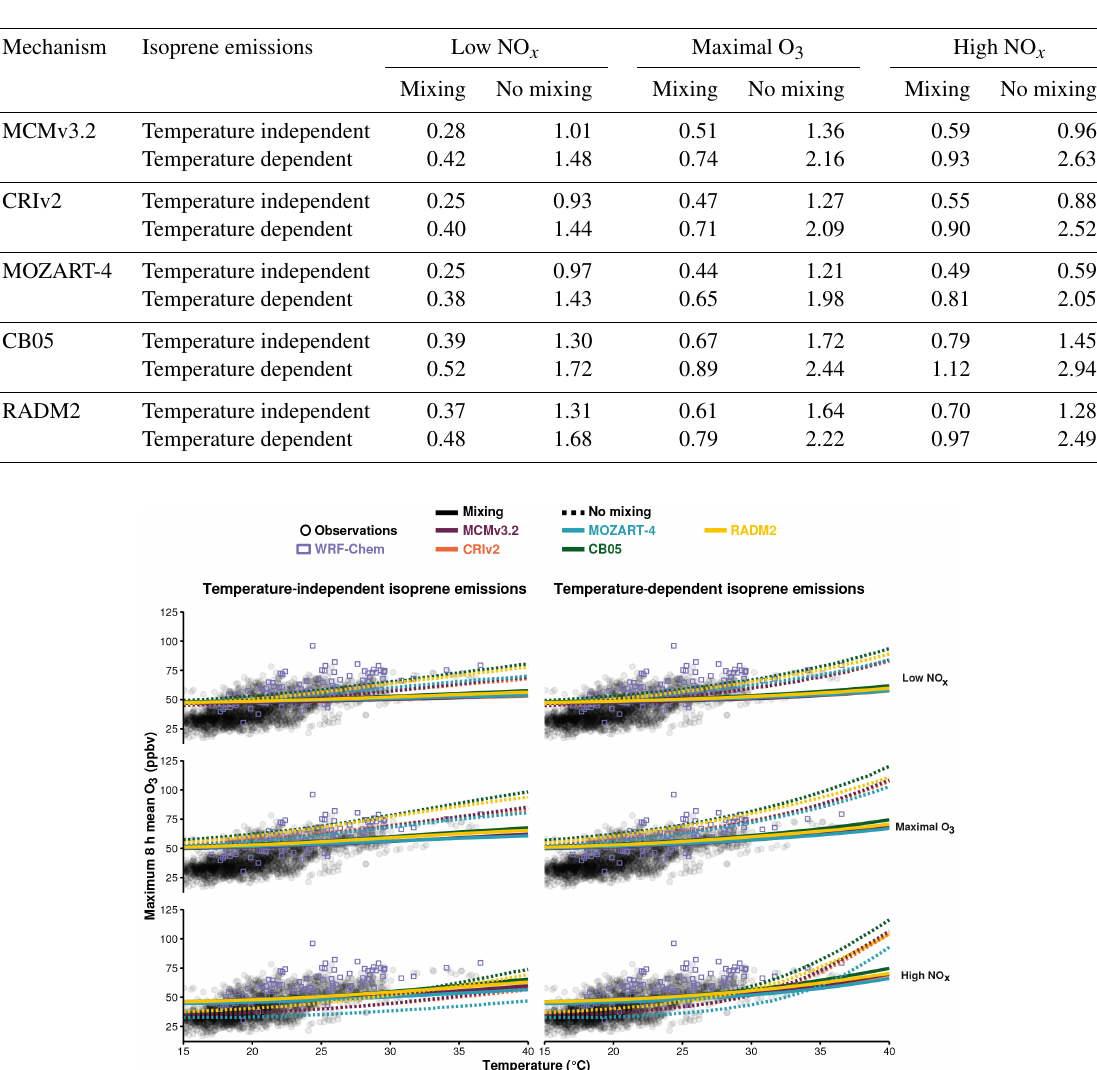
Figure 5. MDA8 values of ozone from the box model simulations allocated to the different NO x regimes for each chemical mechanism with mixing (solid lines) and without mixing (dashed lines). The slopes of the box model ozone–temperature correlation is compared to the summer 2007 observational data (black circles) and WRF-Chem output (purple boxes) in Table